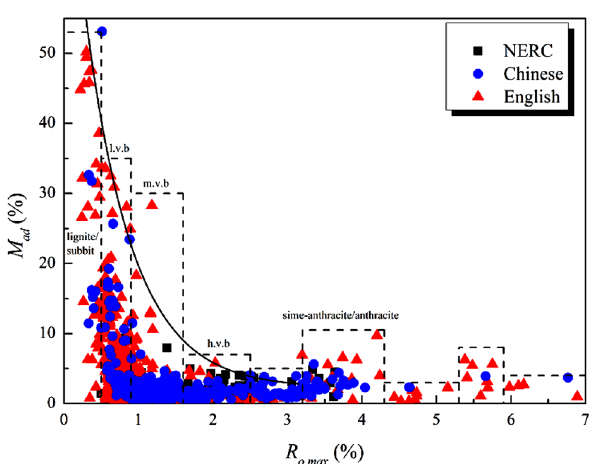
Fig. 6 Variation of M ad with vitrinite reflectance R o ; max . (Data size: NERC-189, Chinese (Yu et al. 2004; Chang et al. 2006; Qin et al. 2007; Chang et al. 2008; Hao et al. 2012; Zheng 2012; Jiang et